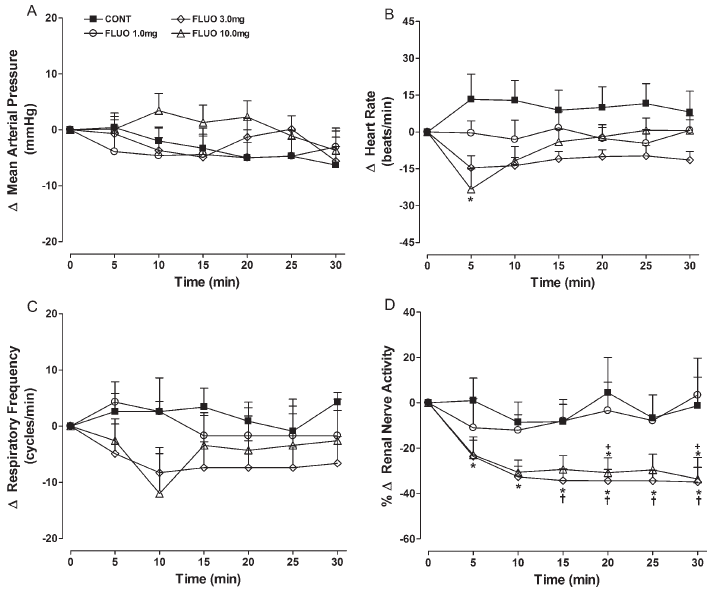
Figure 1. Effects of iv fluoxetine (1, 3, and 10 mg/kg) administration on mean changes ( D ) in A , mean arterial pressure; B , heart rate; C , respiratory frequency; D , renal nerve activity. Data are reported as means±SE for n=7 rats per group. CONT: control; FLUO: fluoxetine (1, 3, or 10 mg/kg). *P , 0.05, FLUO (1, 3, and 10 mg/ kg) vs CONT; { P , 0.05, 3 mg/kg FLUO vs 1